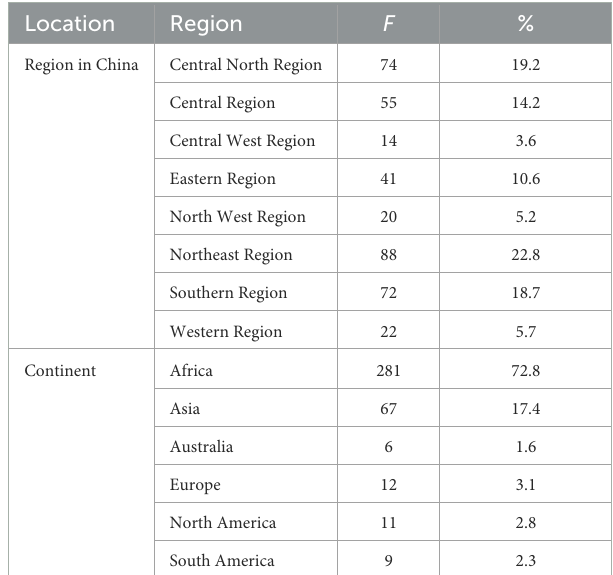
TABLE 2 Regional location of the participants ( N =